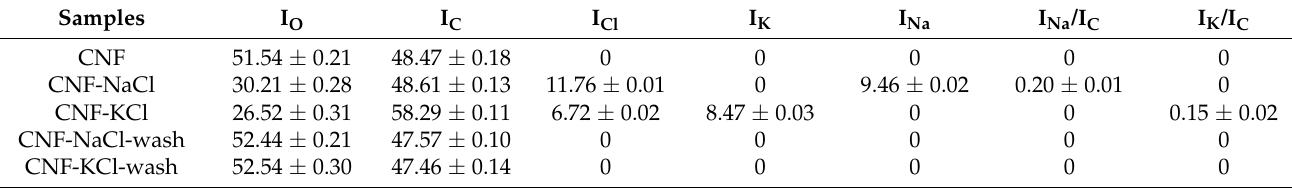
Figure 3. Particle size distributions of CNF 0 , CNF, CNF-NaCl, CNF-KCl, CNF-NaCl-wash and CNF-KCl-wash after redispersion in aqueous solution. Table 1. Intensity value of the tested atom and complexation index measured by